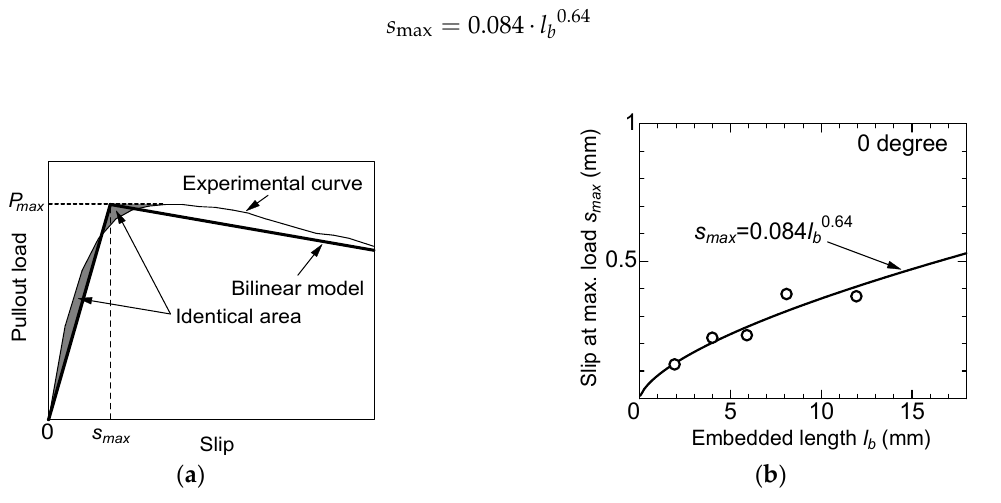
Figure 14. Methodology of determining the slip at the maximum load: ( a ) First line of the bilinear model with an equivalent complementary energy; ( b ) Relationship between slip at the maximum load and the embedded length of the fiber.